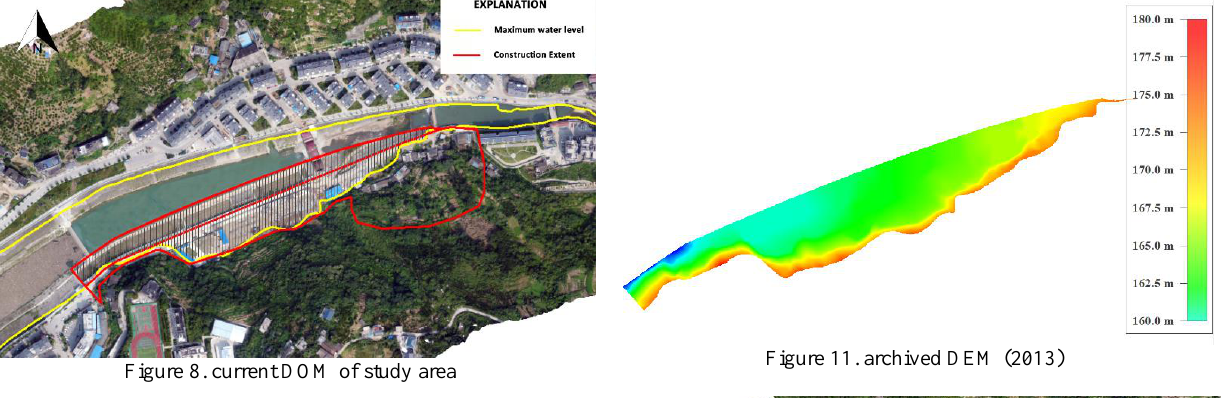
Figure 11. archived DEM (2013)